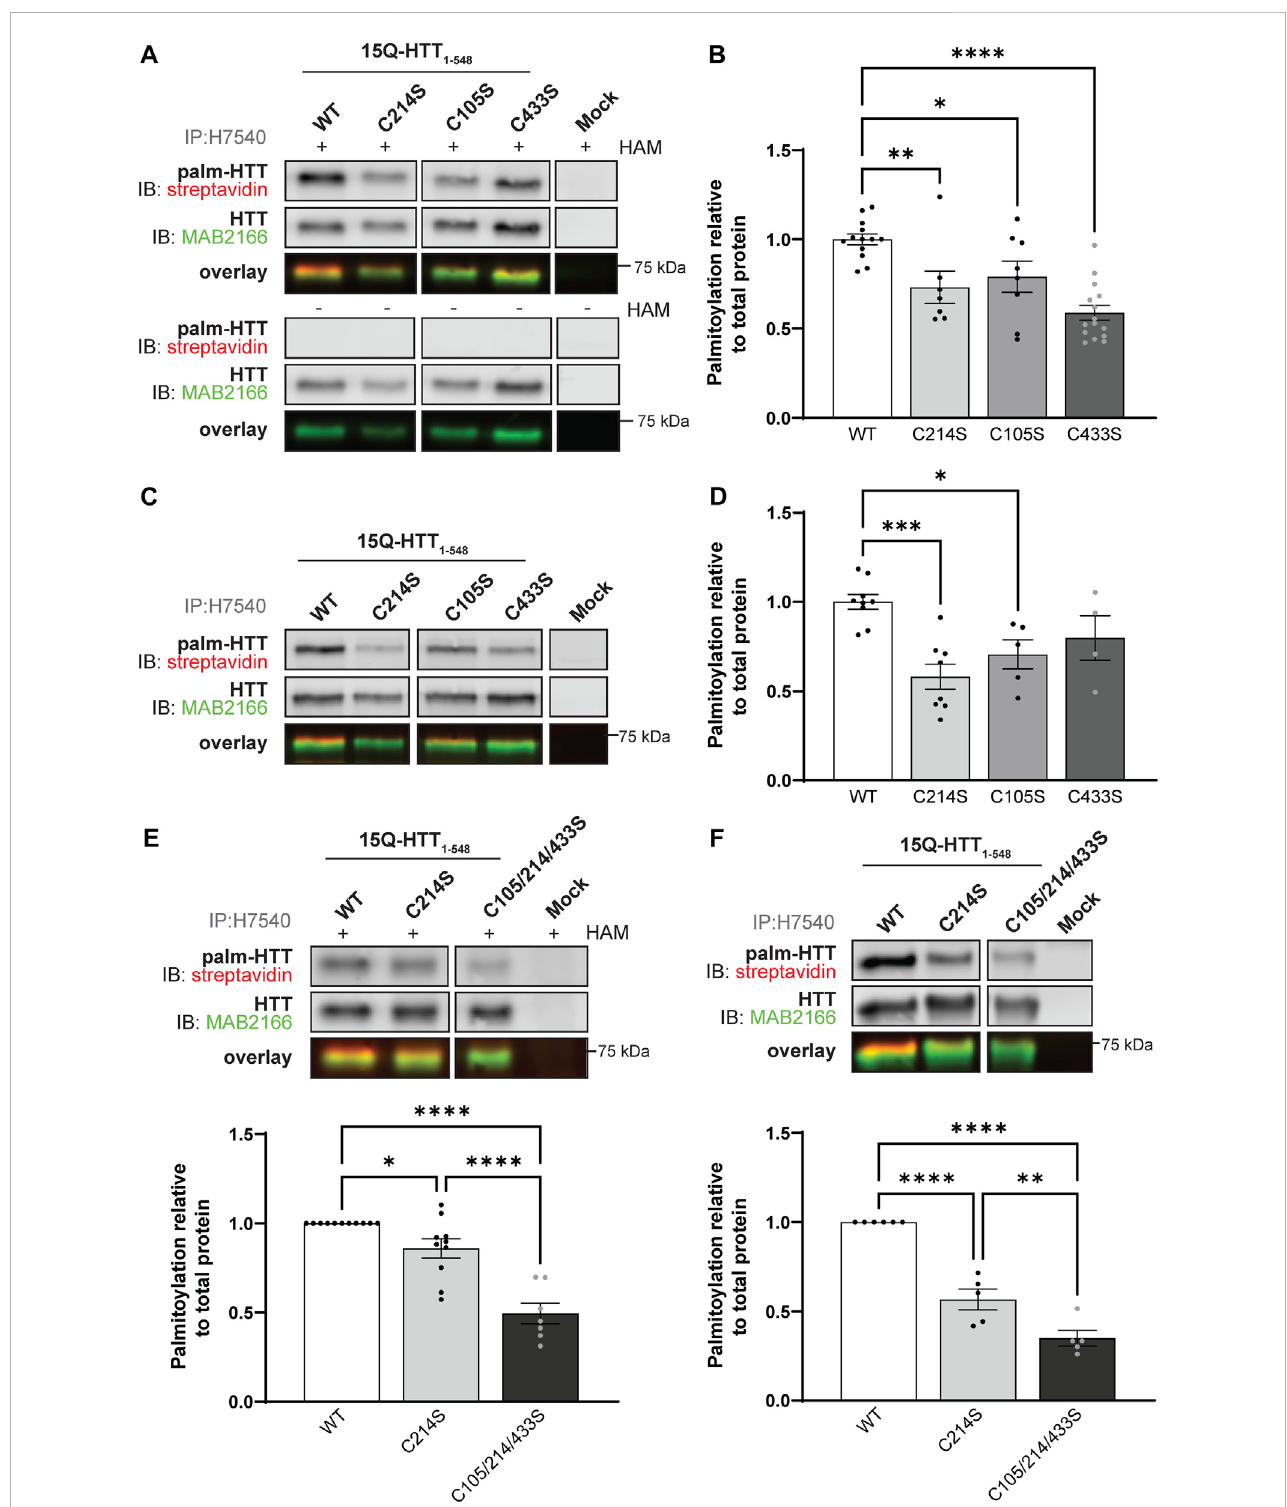
FIGURE 2 Huntingtinispalmitoylatedatcysteines105and433. (A) COS-7cellstransientlyexpressing15Q-HTT 1-548 WTorcarryingcysteine-to-serinemutationsat residues214(C214S),105(C105S)or433(C433S)wereharvested48 hpost-transfection,andsubjectedtotheIP-ABEassay.Mocktransfectionswereincluded to determine baseline background levels. Proteins were immunoprecipitated from lysates using N-terminal HTT antibodies (H7540). Palmitoylated HTT labeled with biotin was detected by western blot analysis using streptavidin, and total HTT with MAB2166 antibodies. The palmitoylation signal (palm- HTT, HAM+) and the negative control treatment (palm-HTT, HAM-) are shown in the top panels, the total HTT protein immunoprecipitated are presented in the corresponding middle panels, and the overlay of the two are displayed in the bottom panels. The western blot images are composites of different lanes from the same image (Supplementary Figure S1), (B) HTT palmitoylation level was calculated as the ratio of palmitoylation over total HTT protein signal, and expressed relative to 15Q-HTT 1-548 WT (n = 7 – 15), (C) COS-7 cells transiently expressing 15Q-HTT 1-548 WT or C214S, C105S and C443S were labeled